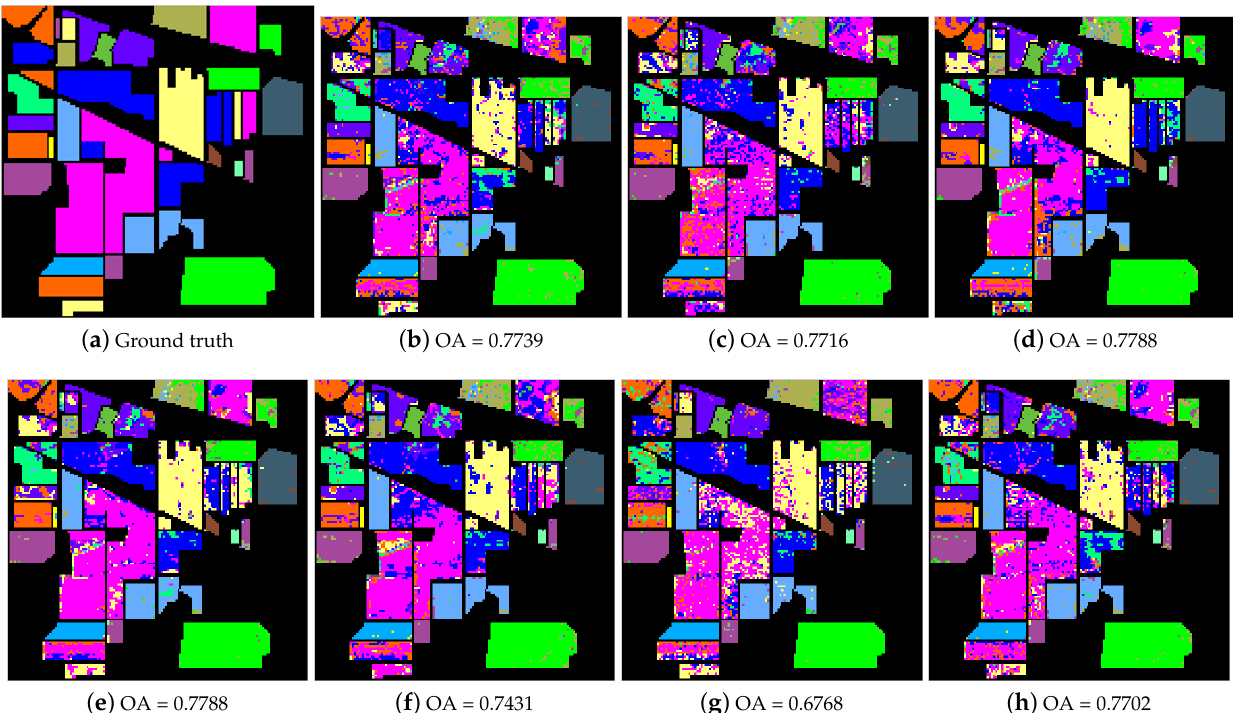
Figure 14. The classification maps of the different tested algorithms. ( a ) Ground truth ( b ) BQUATE2-S1i-SVM ( c ) BQUATE2- V1i-SVM ( d ) BQUATE1-U1-SVM ( e ) BQUATE1-Z1-SVM ( f ) SVM ( g ) PCA-SVM ( h )